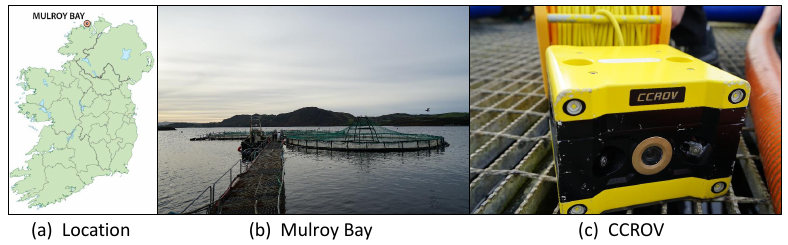
Figure 7. Real scene and related information. ( a ) site location; ( b ) Mulroy Bay; and ( c ) CCROV.